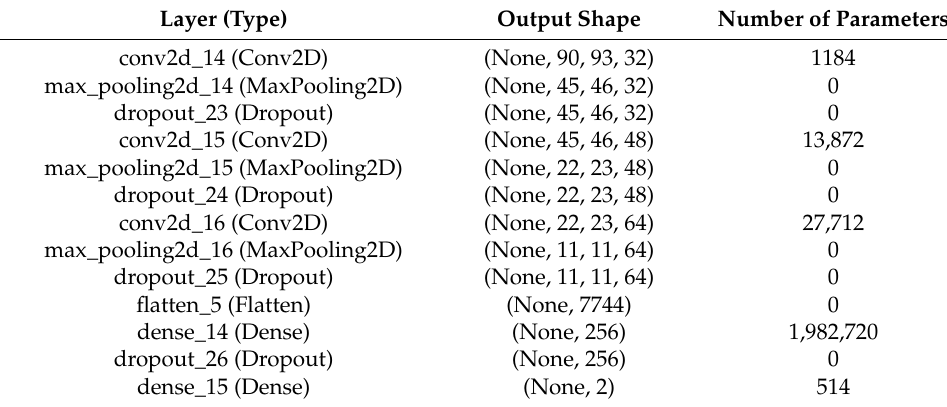
Table 4. The second model of the network used in Experiment 7.